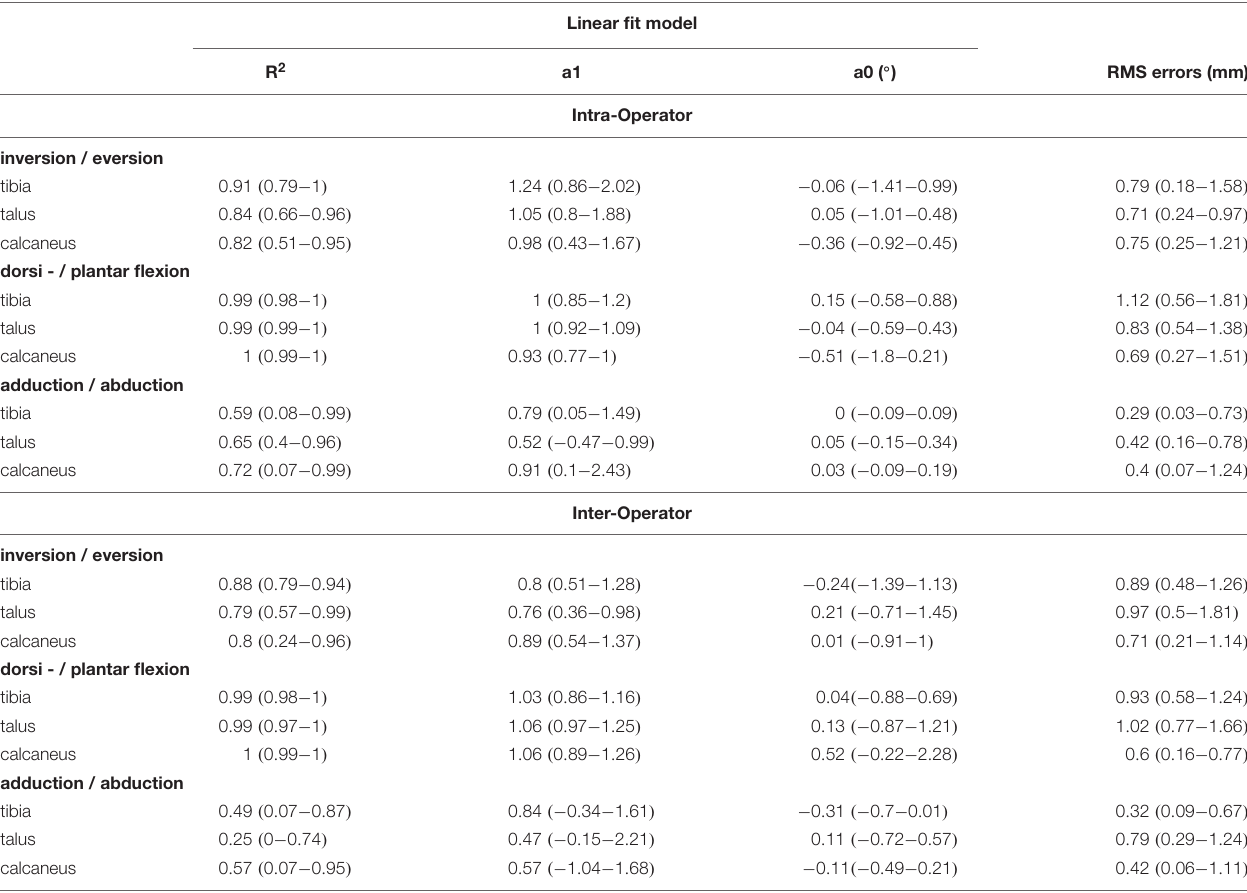
TABLE 3 | Reliability scores for joint kinematics: motion of the talus relative to the tibia (talus-tibia) and calcaneus relative to the tibia (calcaneus-tibia) and talus (calcaneus